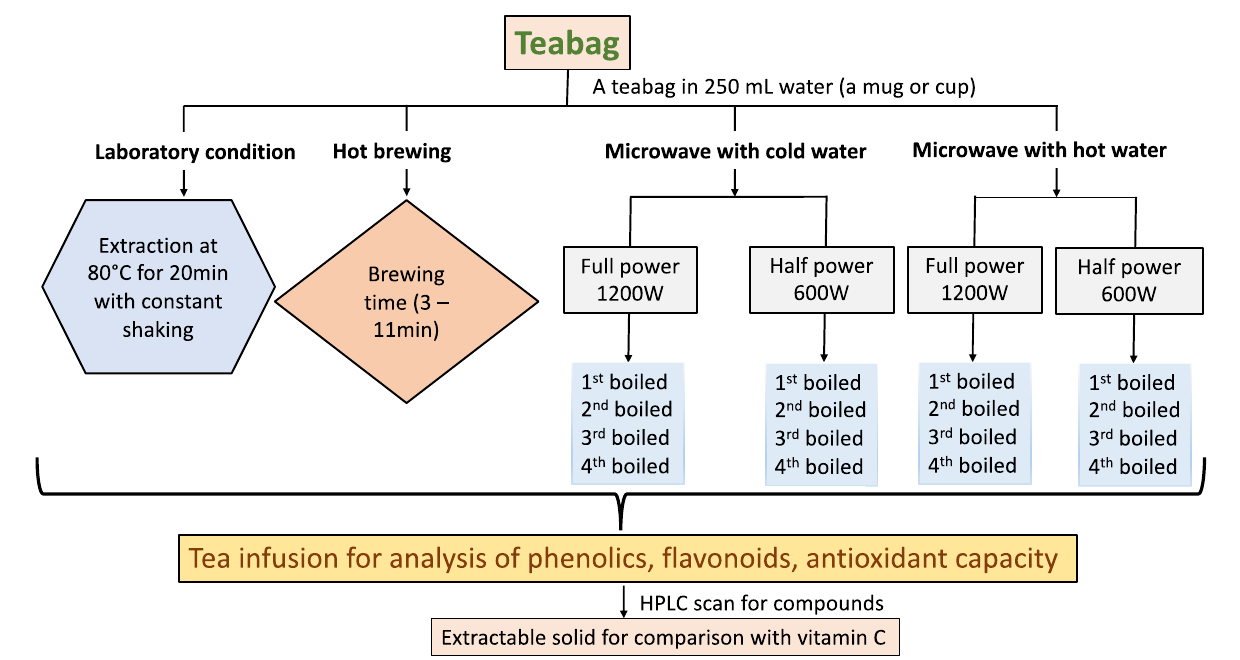
Figure 1. Experimental design of the current study .